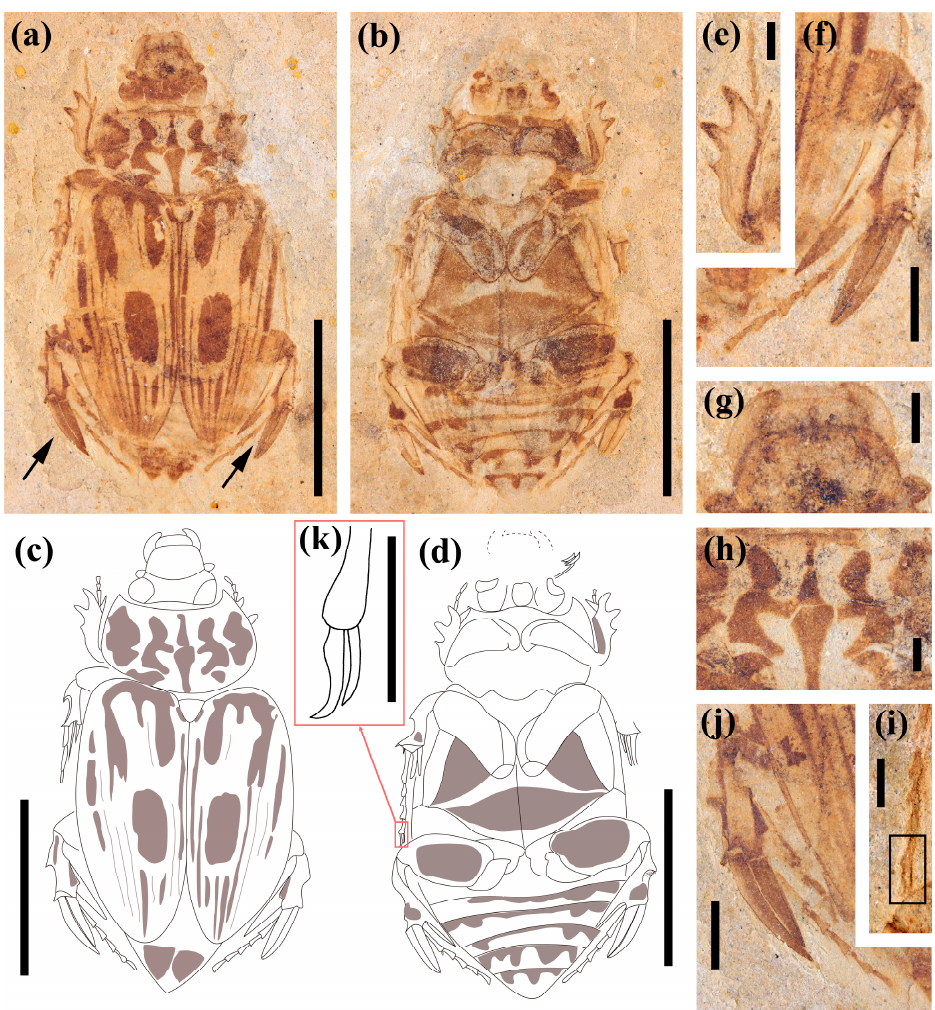
Figure 1. Photographs and line drawings of Antiqusolidus maculatus Lu, Ahrens, Bai, Shih & Ren gen. et sp.n. Holotype. ( a , c ) General habitus, dorsal view; arrows indicate structured hind legs, scale 10 mm. ( b , d ) General habitus, ventral view, scale 10 mm. ( e ) Left foreleg, dorsal view, scale 1 mm. ( f ) Right hind leg, dorsal view, scale 2 mm. ( g ) Anterior part of head, dorsal view, scale 1 mm. ( h ) Pronotum, scale 2 mm. ( i ) Right mesotarsi, ventral view, rectangle indicate claws, scale 1 mm. ( j ) Left hind leg, dorsal view, scale 2 mm. ( k ) Claws of right mesotarsi, scale 1